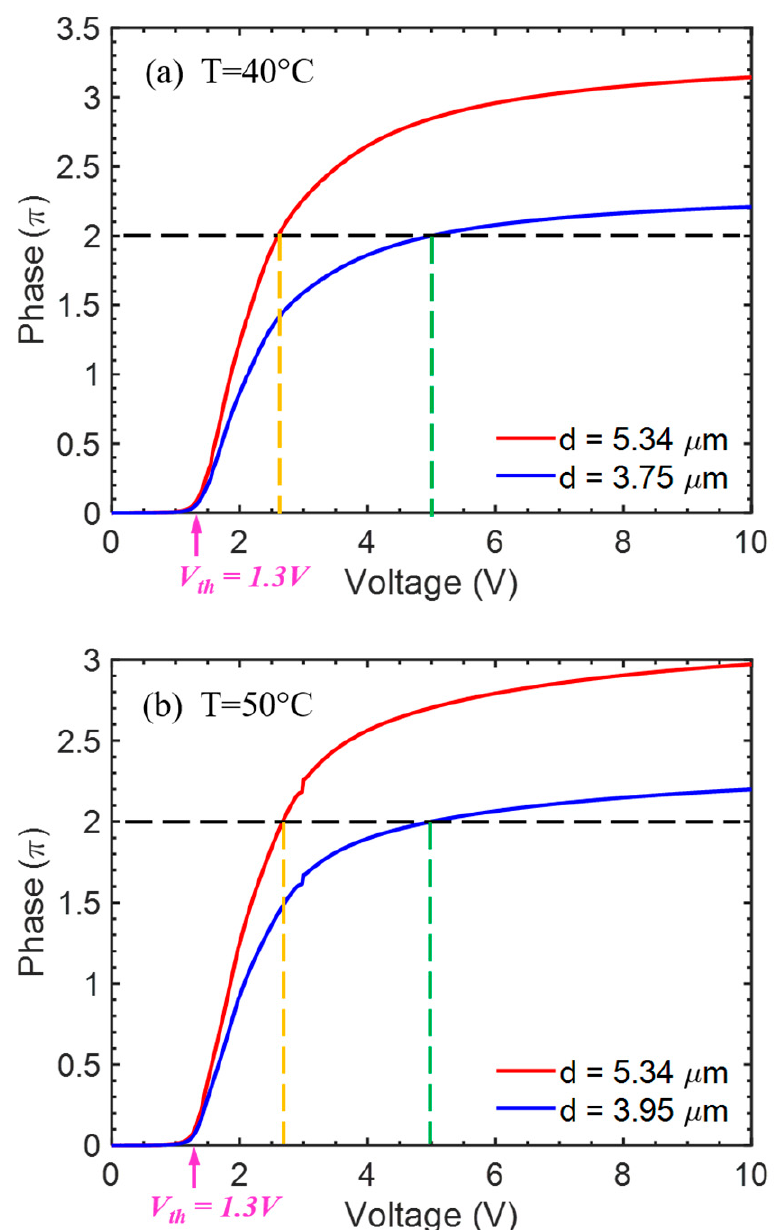
Figure 5. Measured (red line) voltage-dependent phase change of a transmissive A4907 test cell at λ = 633 nm and 1 kHz. Cell gap is d = 5.34 µ m, with V 2 π = 2.6 V rms at T = 40 ◦ C in ( a ) and V 2 π = 2.7 V rms at T = 50 ◦ C in ( b ). If we operate A4907 at 50 ◦ C, we could use a slightly thinner cell gap (3.95 µ m transmissive cell or 1.98 µ m reflective LCoS, blue line in ( b )) to increase V 2 π to 5 V rms